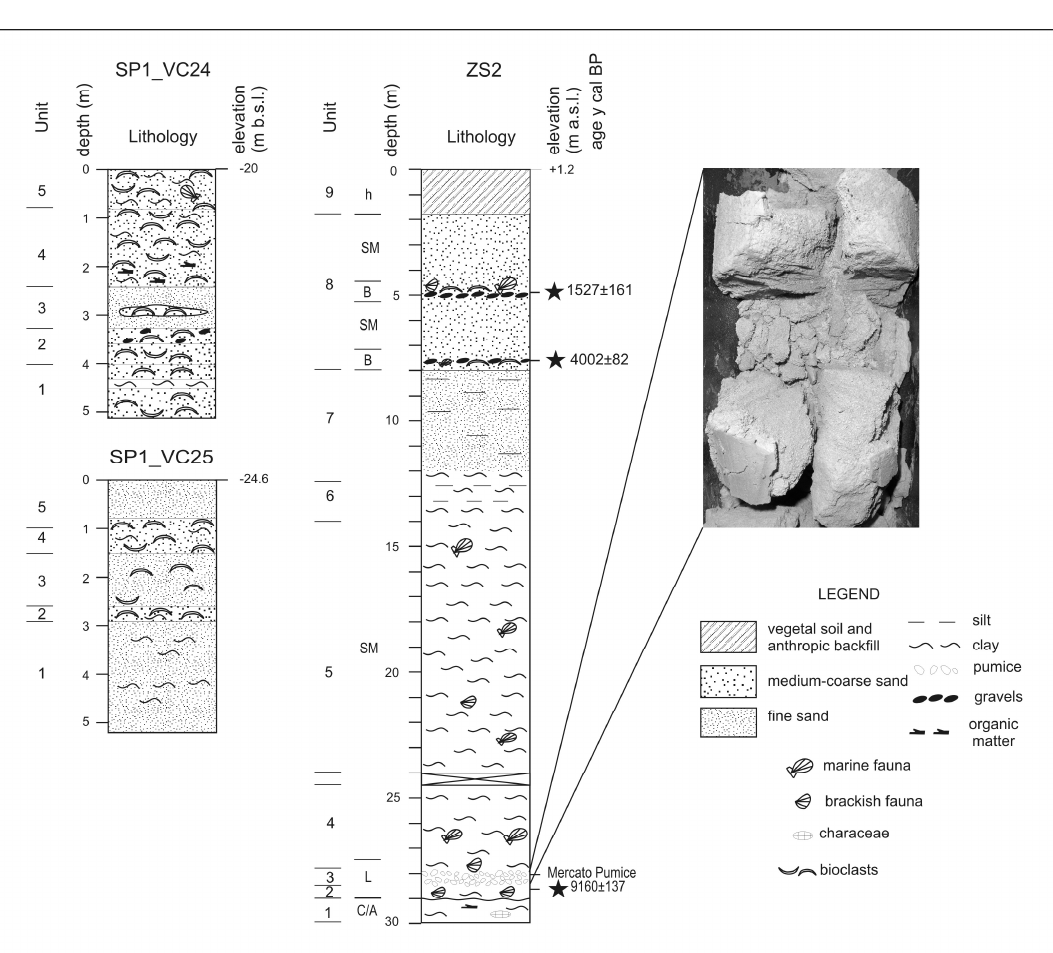
Figure 7. Stratigraphic logs of ZS2 borehole and SP1_VC24 and SP1_VC25 vibro-cores; a photo showing a particular of the Mercato pumice layer in ZS2 borehole has been reported. C/A = continental/alluvial; L = lagoonal; SM = shallow marine; B = beach; h = anthropic. 9. from 24.0 to 14.0 m (−22.8 to −12.8 m b.s.l.), grey, dark grey, or leaden clay, generally with abundant and diversified fauna: Tellina distorta (Poli), Corbula gibba (Olivi), M. bidentata , Pitar rudis (Poli), Gouldia minima (Montagu), A. nitida , Nuculana pella (Linneo), N. nitidosa , and D. 10. from 14.0 to 12.45 m (−12.8 to −11.25 m. b.s.l.), dark grey clay layers alternating with a thin layer of light grey silt containing rare specimens of A. nitida , C. gibba , N. pella , N.a nitida , and Odostomia sp.;